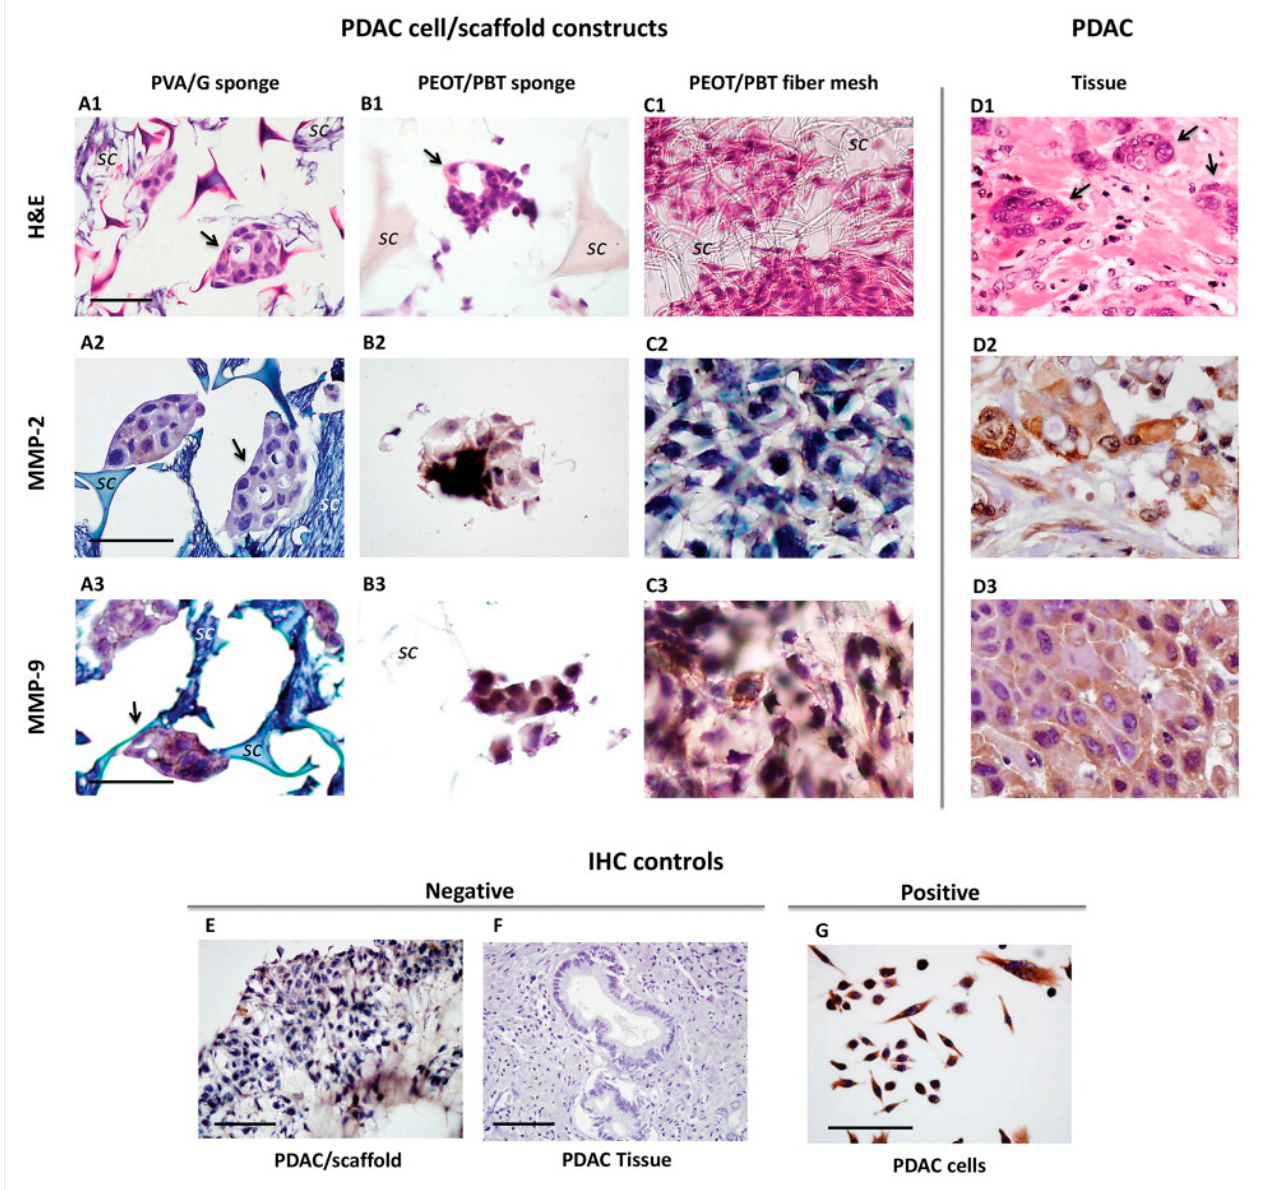
Figure 2. Histological micrographs of ( A – C ) pancreatic ductal adenocarcinoma (PDAC) cell/scaffold constructs, and ( D ) tumor tissue: ( A ) PVA/G spongy scaffold prepared via emulsion and freeze- drying, ( B ) PEOT/PBT spongy scaffold prepared via compression molding and salt leaching, and ( C ) PEOT/PBT fiber mesh prepared via electrospinning. ( A1 – D1 ) Hematoxylin and eosin staining, and ( A2 – D2 , A3 – D3 ) immunohistochemistry for metalloproteinases (MMPs) MMP-2 and MMP-9. Arrows indicate some organized clusters of cells with duct formation; “sc” indicates the scaffold material. ( E – G ) Controls of immunohistochemical reactions. Scale bar is 50 µm. (Reprinted from